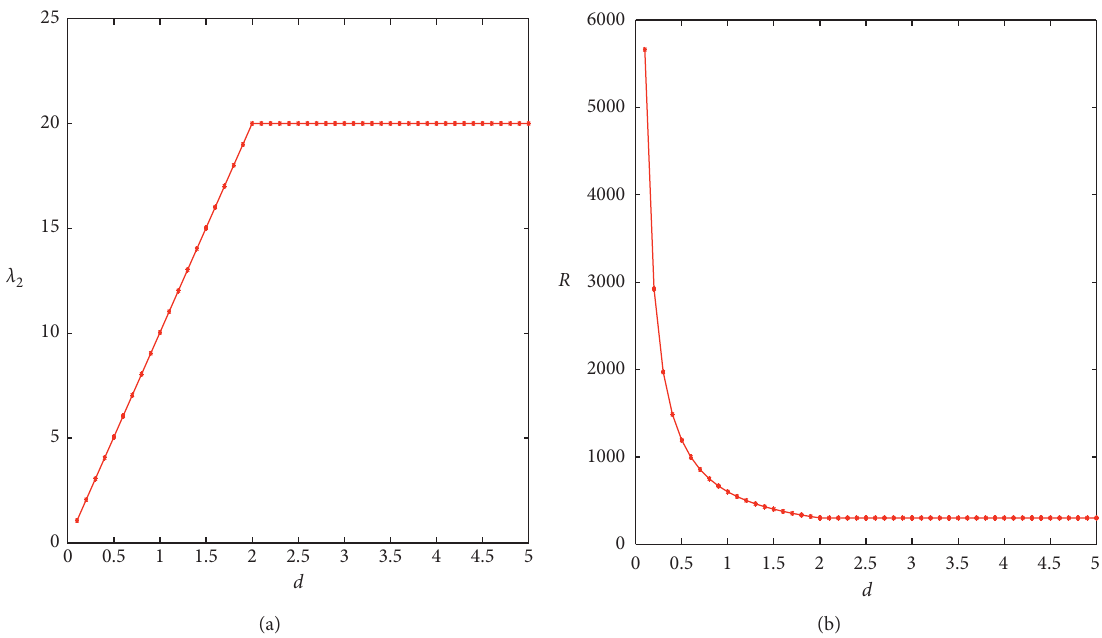
Figure 5: The synchronizability of multilayer star networks vs . varying the interlayer coupling strength d ( N � 300, M � 10, a � 20, and d 0 � 2). (a) λ 2 with respect to varying d . (b) R with respect to varying